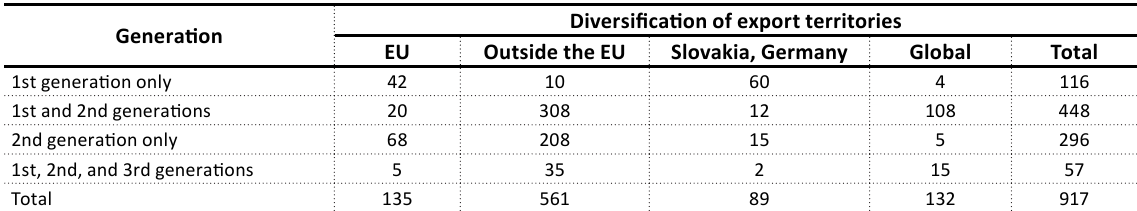
Table 5. Diversification of export territories and generational involvement in the management